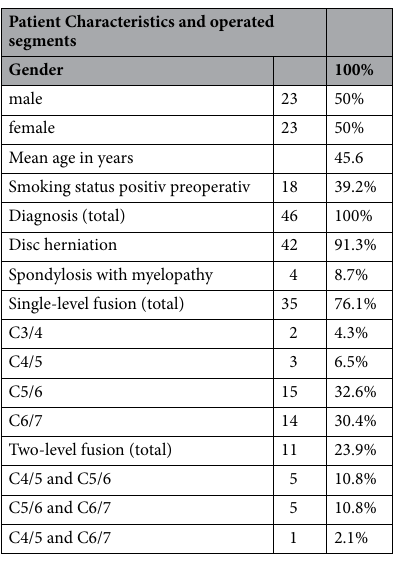
Table 2. Patient characteristics and operated